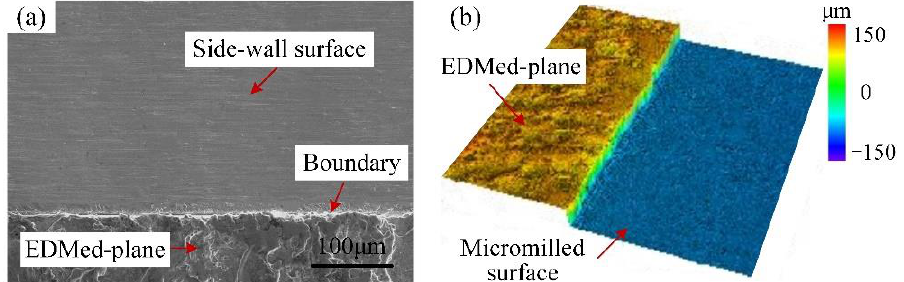
Figure 11. Surface morphology of the bottom boundary of side-walls by carbide cutter. ( a ) 2D morphology; ( b ) 3D morphology.